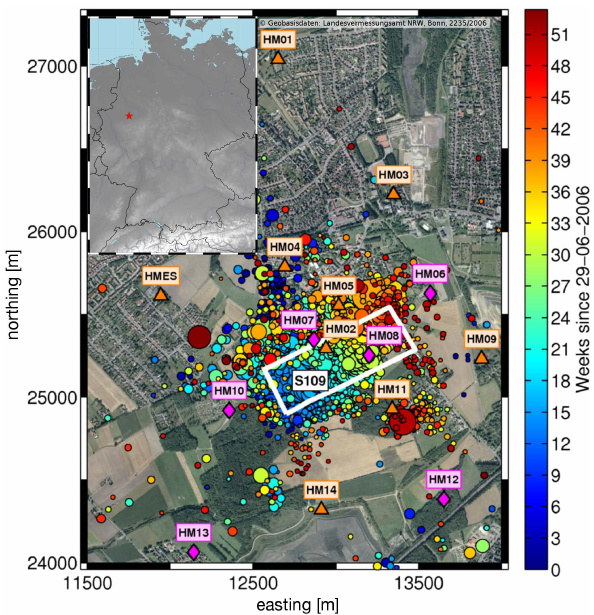
Fig. 1. Map showing the stations of the temporary seismic network HAMNET, the longwall S109 and the recorded seismic events. Diamonds denote broadband and triangles short period stations. Colours of the events depict the time of occurrence and the size of the circle scales with event